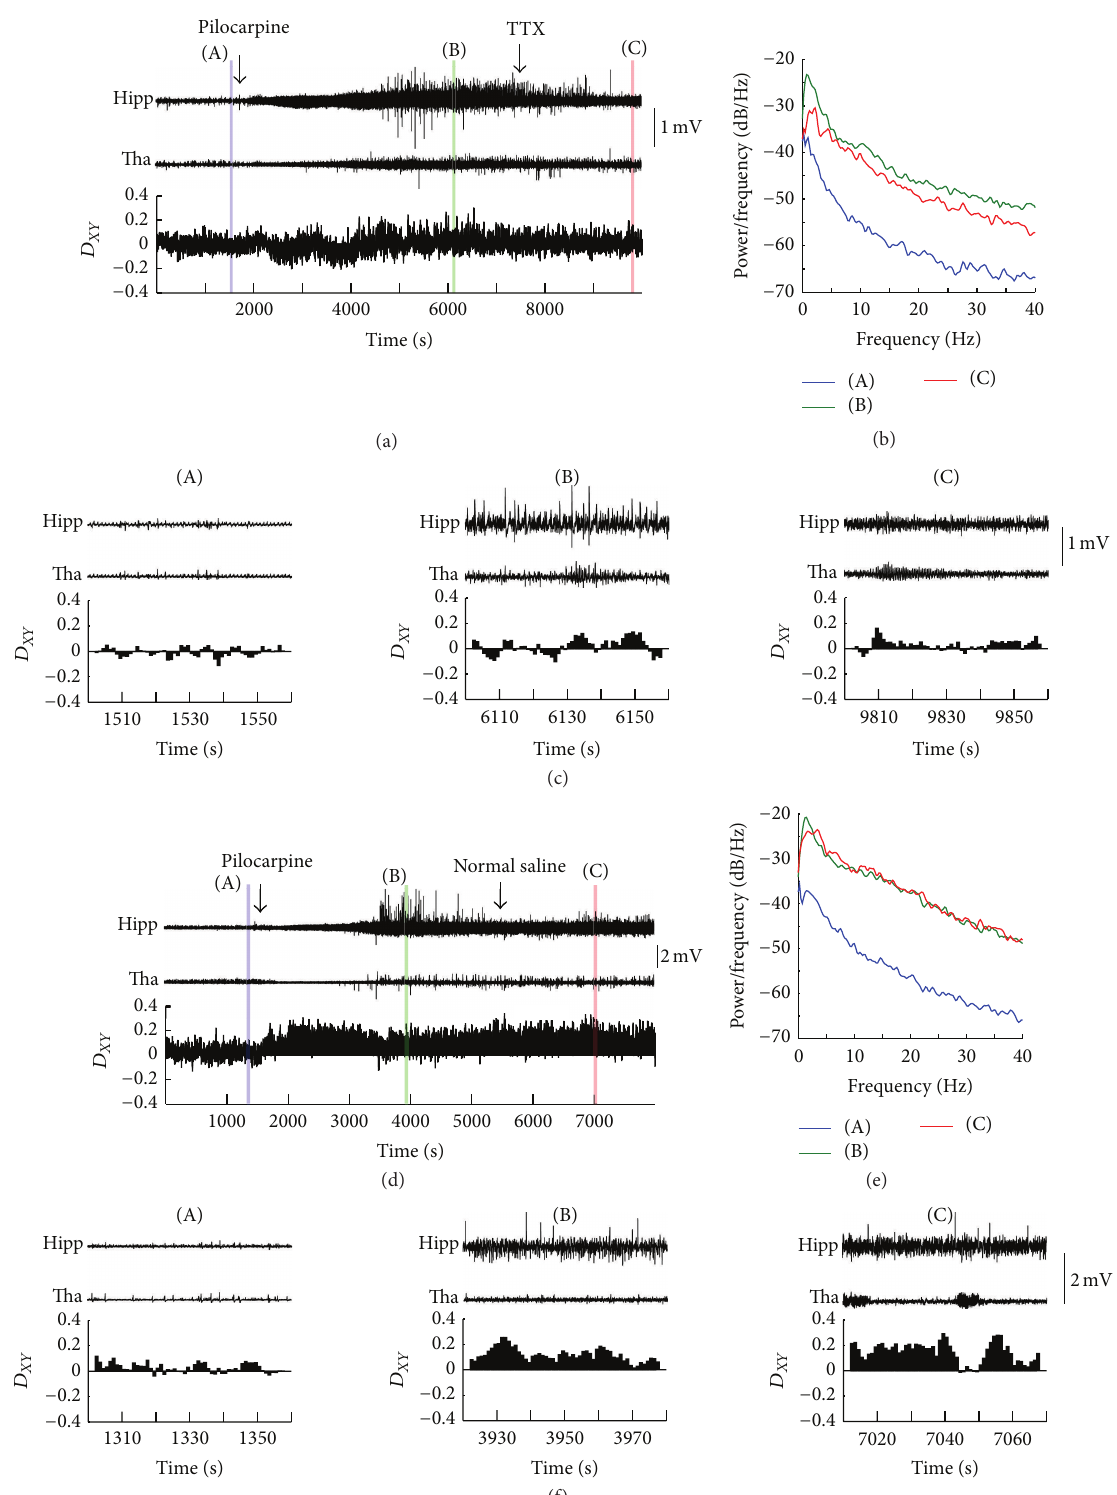
Figure 7: Seizures affected by the TTX injection in thalamus. (a) LFPs from hippocampus and thalamus and the averaged directionality index ( 𝐷 𝑋𝑌 ) between the two brain areas before and after the injection of TTX into thalamus. (b) The power spectral density of the LFPs in hippocampus (shadowed areas in (a)). (c) 60-second samples from each trace in (a) (the shadowed areas). (d) LFPs from hippocampus and thalamus and averaged directionality index ( 𝐷 𝑋𝑌 ) between the two brain areas before and after the injection of normal saline into thalamus in a control mouse. (e) The power spectral density of the LFPs in hippocampus (shadowed areas in (d)). (f) 60-second samples from each trace in (d) (the shadowed areas). Hipp, hippocampus; Tha,